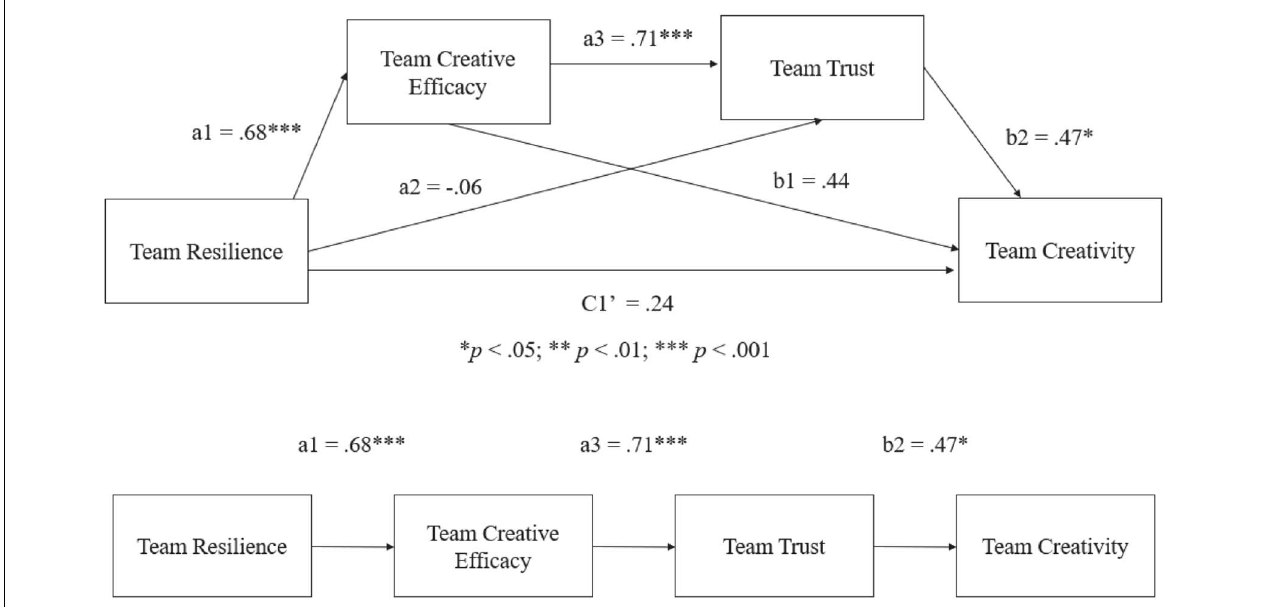
FIGURE 2 | The results of the sequential model with path